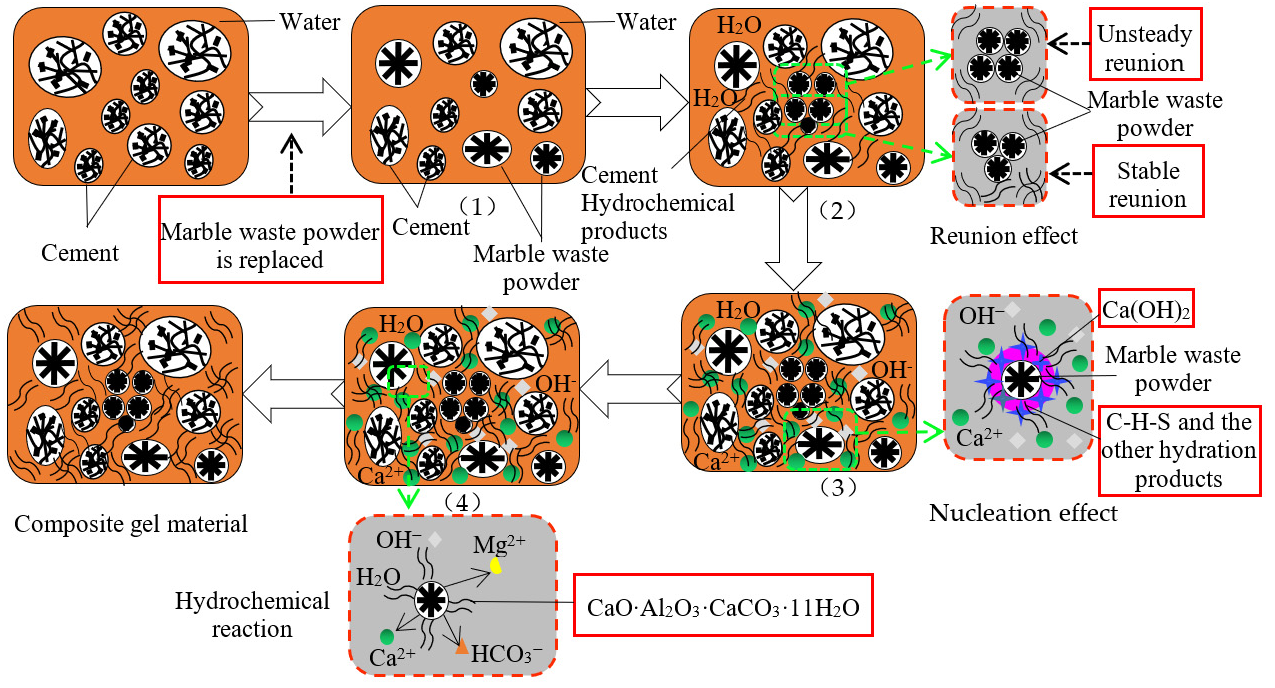
Figure 15. Mechanism of the action model of marble waste powder of the composite gel